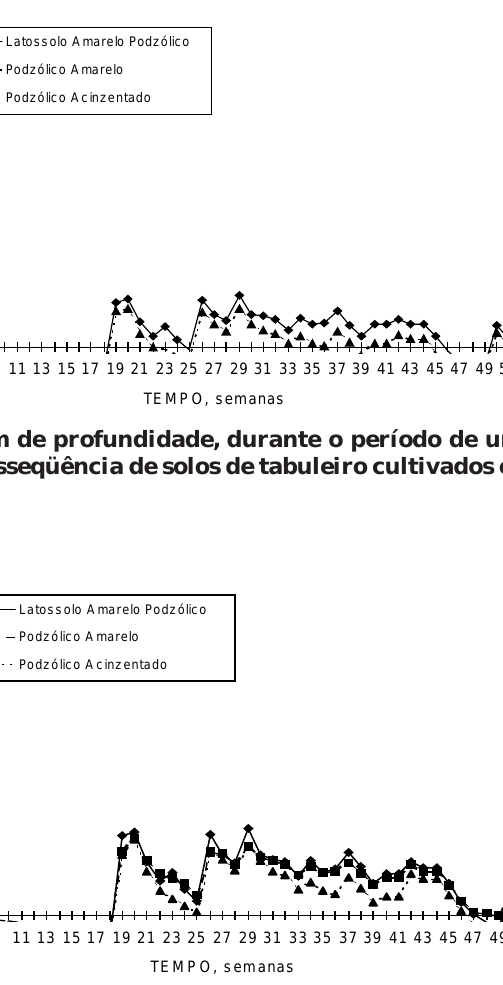
Figura 4. Água disponível até 0,50 m de profundidade, durante o período de um ano, a partir de 18 de dezembro de 1995, em uma toposseqüência de solos de tabuleiro cultivados com citros, no município de Sapeaçu (BA).